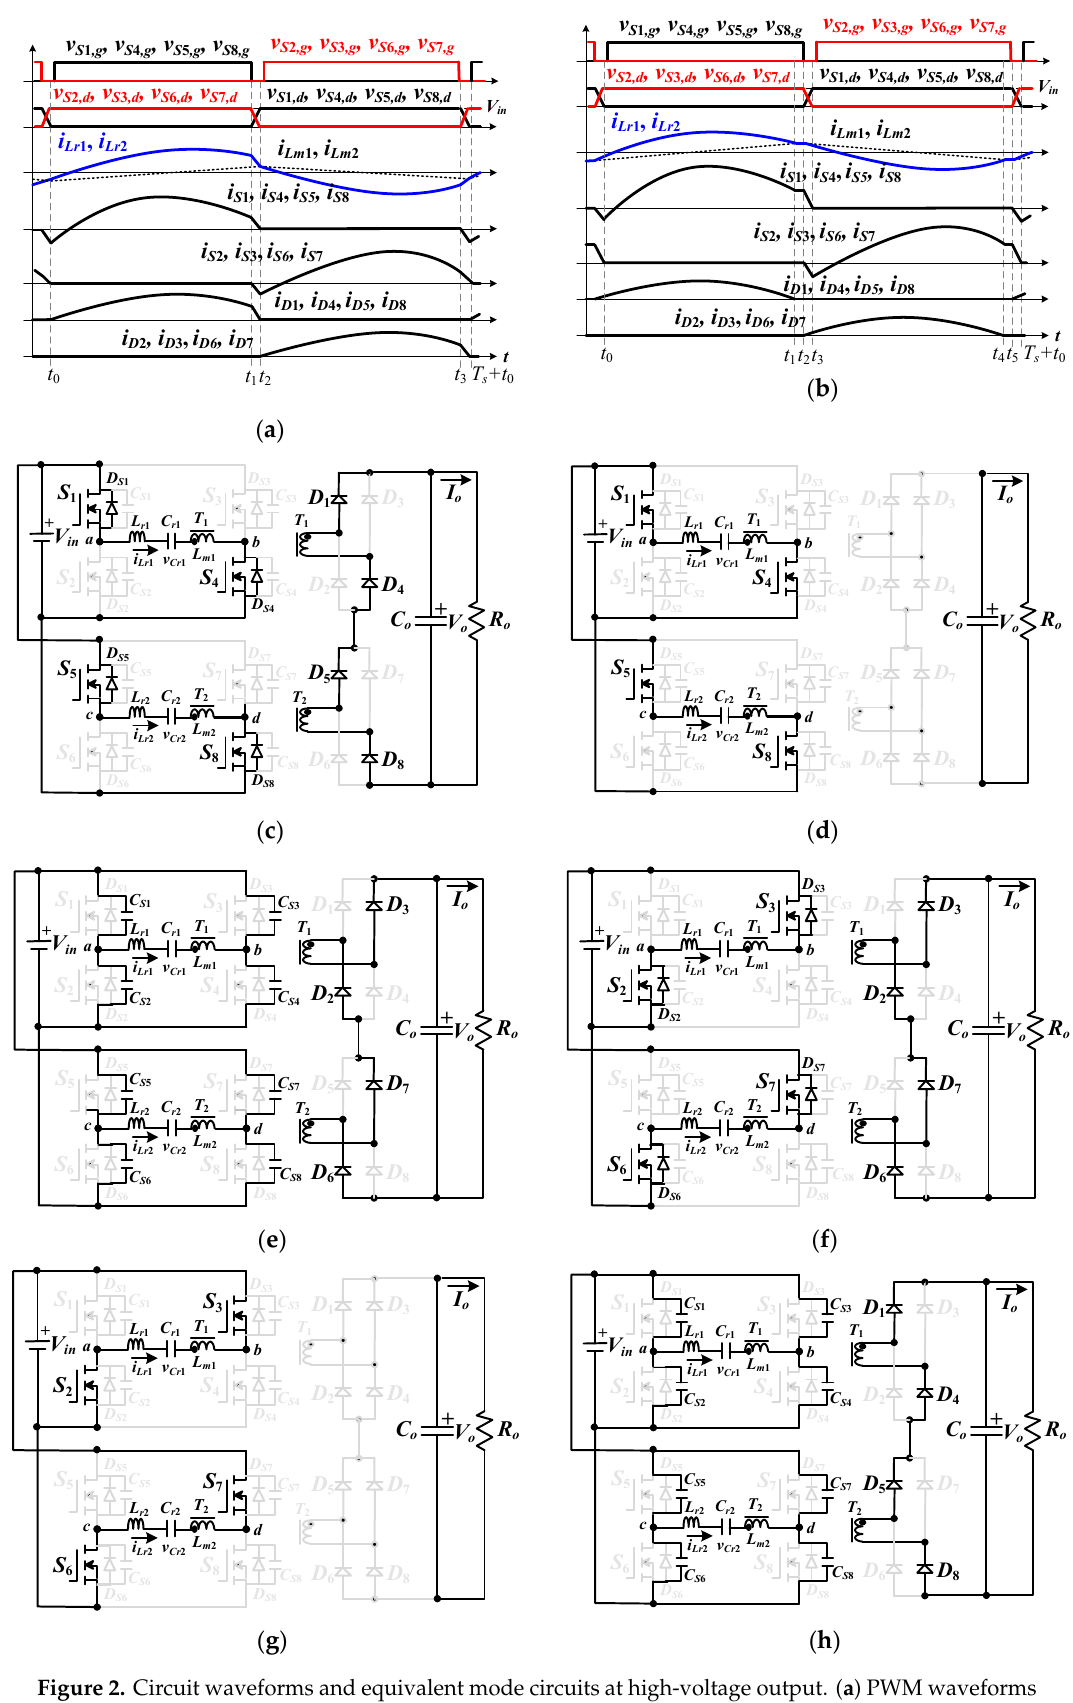
Figure 2. Circuit waveforms and equivalent mode circuits at high-voltage output. ( a ) PWM waveforms when f s > f r ; ( b ) PWM waveforms when f s < f r ; ( c ) mode 1; ( d ) mode 2; ( e ) mode 3; ( f ) mode 4; ( g ) mode 5; and ( h ) mode 6.